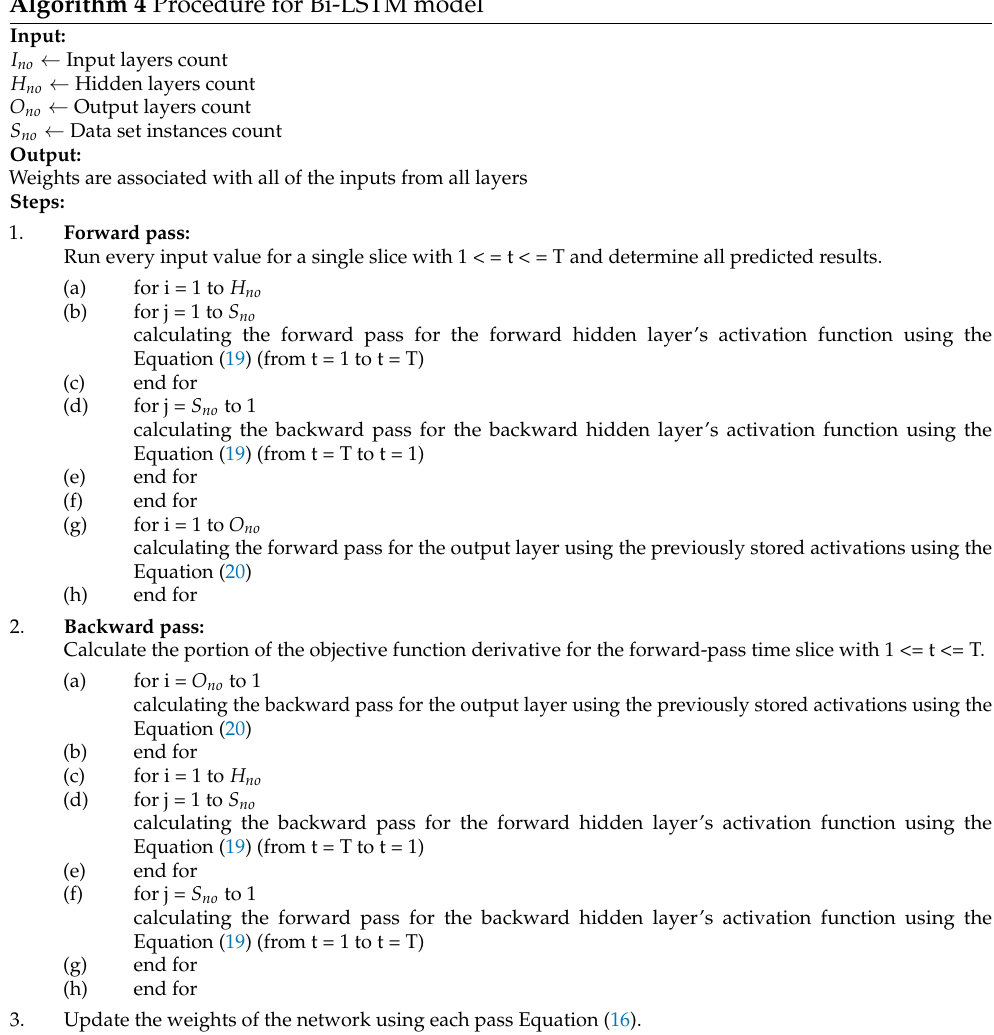
Algorithm 4 Procedure for Bi-LSTM